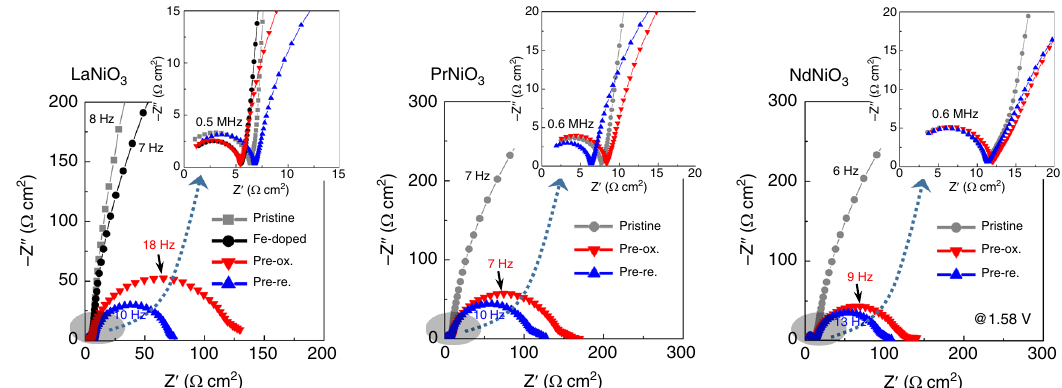
Fig. 4 Electrochemical impedance spectroscopy. In contrast to the low-frequency arcs of pristine fi lms, considerably small arcs with very short diameters are noted for the surface-Fe-exchange fi lms, and as a common feature in all three nickelates, indicating remarkably low charge-transfer resistance ( R CT ) between the fi lms and electrolytes. As can be seen in each magni fi ed inset for the high-frequency range, denoted by a gray shadow, the electrolyte resistance ( R E ) values hardly differ between the samples in each of the image, were compared with the unit-cell image showing four is provided in Supplementary Fig. 16 to con fi rm the undistorted oxygens placed immediately at the corners of a white rhombus for oxygen octahedra as a standard. a Ni octahedron in the bulk (upper right panel). The comparison ABF-STEM is one of the imaging techniques commonly used directly shows that most oxygens have been considerably dis- for visualizing the position of light elements including oxy- placed from their original positions in the bulk, as indicated by a gen 20,45 – 50 . However, because atomic columns are imaged in this STEM mode using a dark contrast with a bright background, the distorted yellow rhombus in each of the images (see Supple- position uncertainty of light elements is sometimes not negligible mentary Fig. 14 for the un fi ltered raw images). Altogether with when a specimen is comparatively thick and its tilting angle is the ABF image obtained from the bulk fi lm in Supplementary high 51,52 . Therefore, to achieve a better signal-to-noise ratio, we Fig. 15, an additional set of ABF images for the surface region used an imaging method, iDPC-STEM, where four-quadrant from the pristine sample without pre-oxidation or pre-reduction